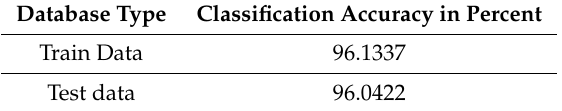
Table A2. The accuracies obtained by the SVM for the train and test sets, by classifying the synthetic database with the best sigma that equals to 0.6.